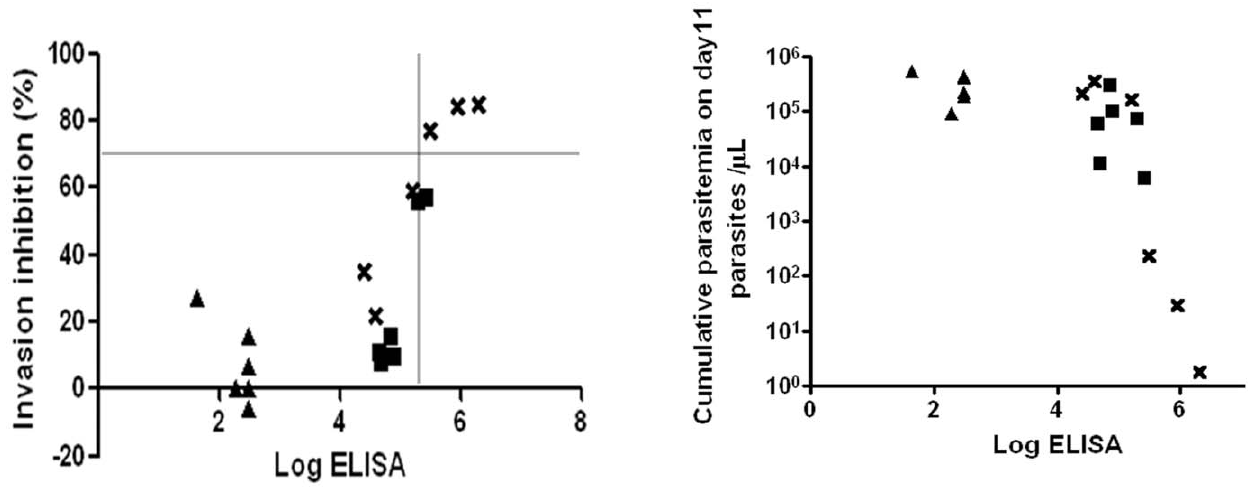
Figure 7. ELISA titers positively correlate GIA activity and negatively correlate parasitemia. Left panel shows GIA activity of the FCH/4 challenged animals plotted against log ELISA titer. Group symbols: PBS + ISA (triangle), AMA + ISA (cross) and AMA + AS02 A (square). The three monkeys that were protected in the study had GIA activity of . 70% and ELISA titer of . 300,000, cut-off indicated by grey lines. Right panel shows the correlation between log ELISA endpoint titer and the cumulative day 11 parasitemia for the 18 FCH/4 challenged animals.